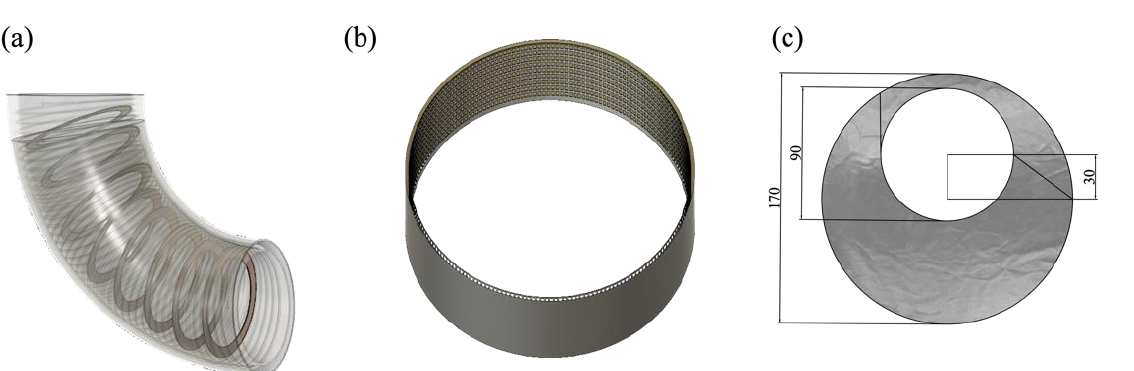
Figure 2. Magnetic-filter duct ( a ) lined with Cu-sheet baffles, ( b ) lined with 304 SS wire meshes along the length of duct, ( c ) with an Al foil inserted at the bend position to provide a round opening. The microstructure of the thickness and surface morphology was analyzed by SEM (JEOL JSM 6500F). The density and dimension of the MPs were observed with SEM and cal- culated by an image analysis system. Several SEM images were taken at low magnification on our films randomly. Then, image J was adopted to calculate the number and diameters of the MPs, and we used the average [28].